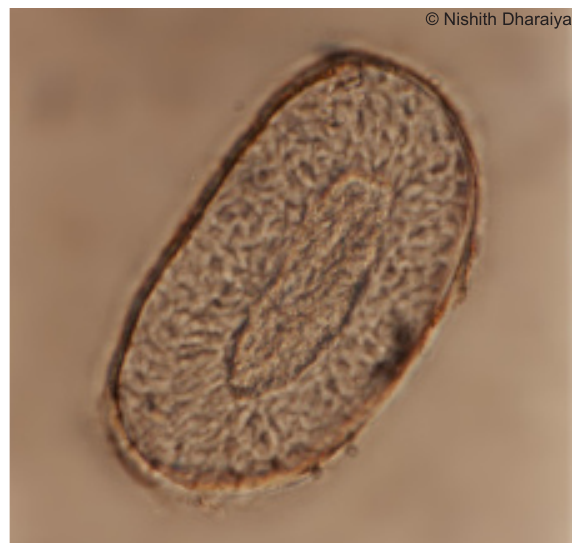
Image 9. Cross section of hair of Ratel